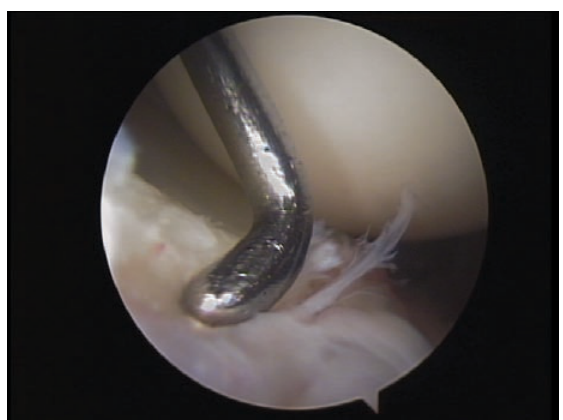
Figure 4. Acute posterior labral tear after punching. Figure 5. Arthroscopic repair of the posterior labral tear with a